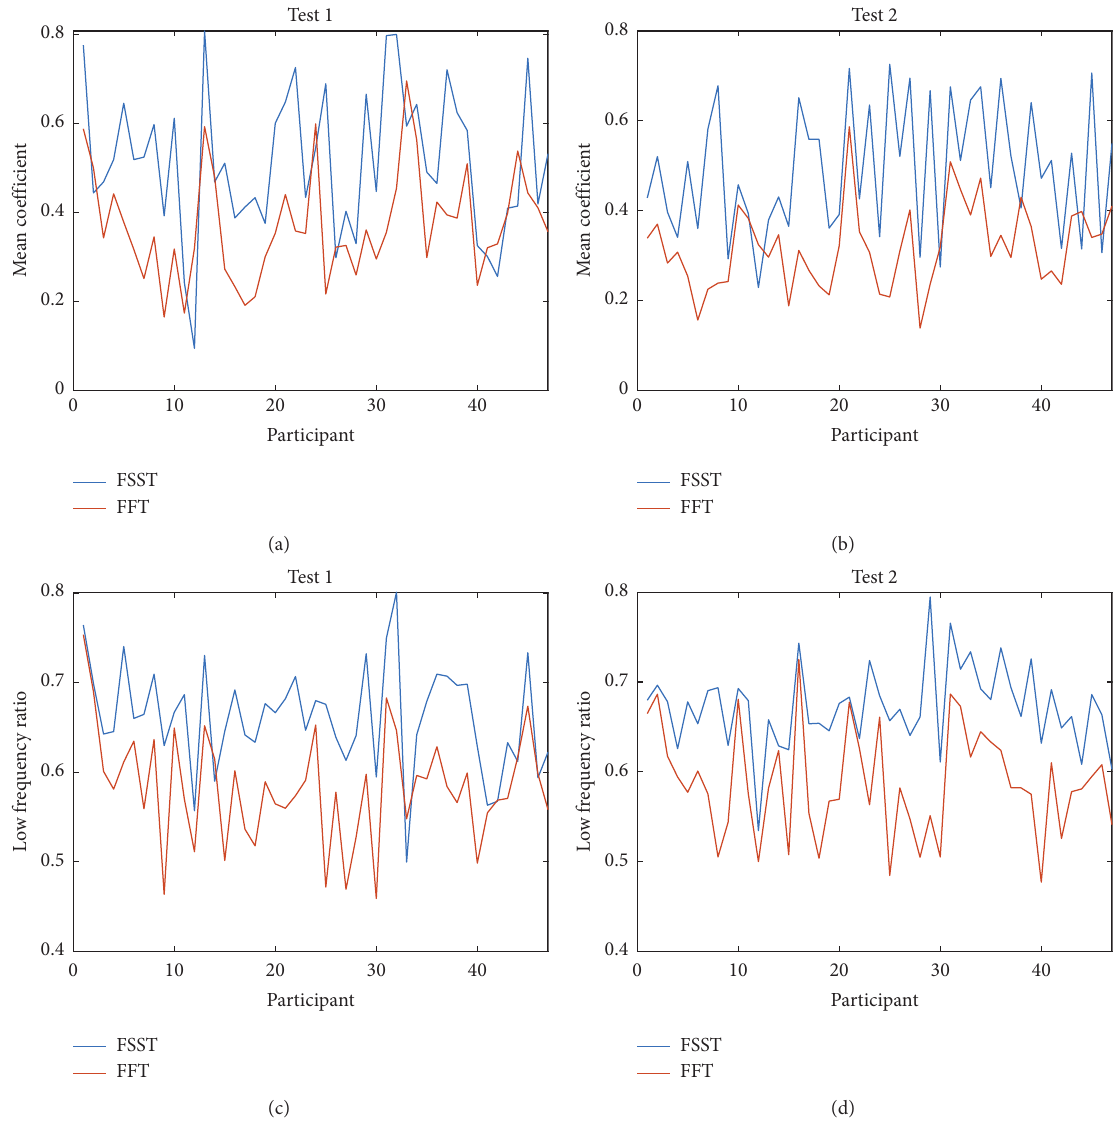
Figure 2: Mean coefficient and low frequency ratio of each participant in low frequency band using FSST and